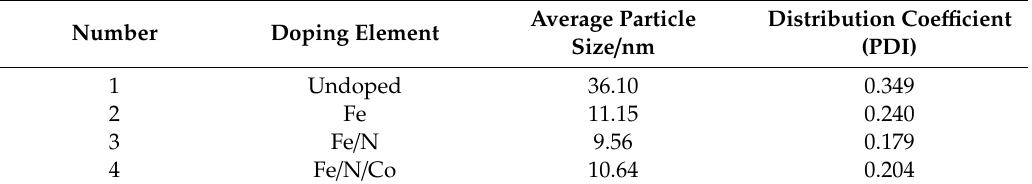
Figure 2. The particle size distribution of doped-TiO 2 with different doping elements. Table 1. The colloidal particle size of Fe, Fe/N, and Fe/N/Co–TiO 2 .